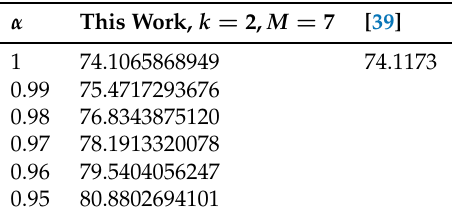
Table 6. Comparison of J ∗ for Example 3.